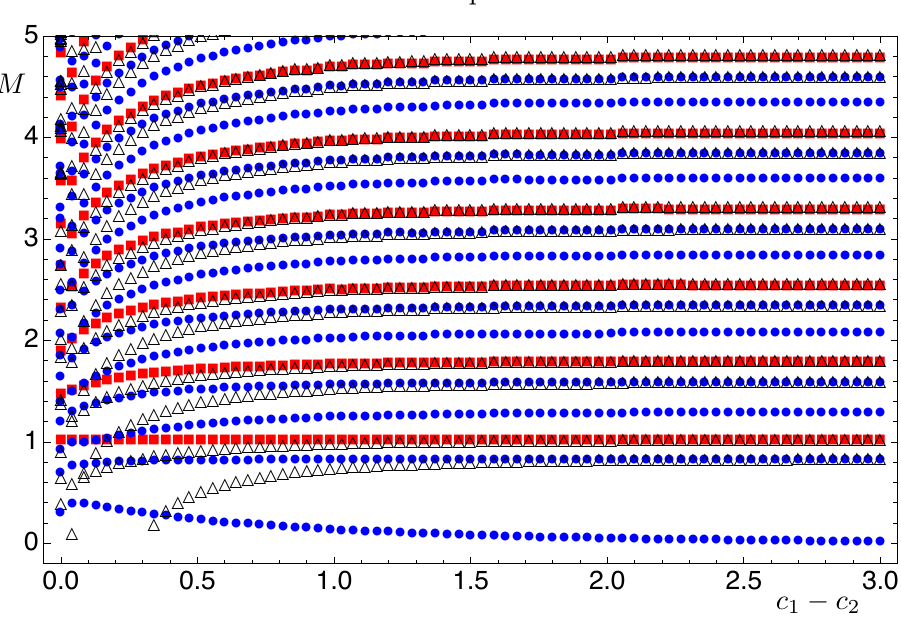
p Figure 3 . Masses M = (cid:0) q 2 of modes in the GPPZ model, as a function of the parameter c 1 (cid:0) c 2 de(cid:12)ned in the main body of the paper. All masses are expressed in units of the mass of the lightest tensor mode. The (red) squares represent the tensor modes, the (blue) disks are the scalar modes, computed with the complete, gauge-invariant variables, while the (black) triangles are the scalar modes recalculated by making use of the probe approximation. The calculations have been performed by setting r 1 = 0 : 001 and r 2 = 10, in order to minimise spurious cuto(cid:11)-dependent e(cid:11)ects